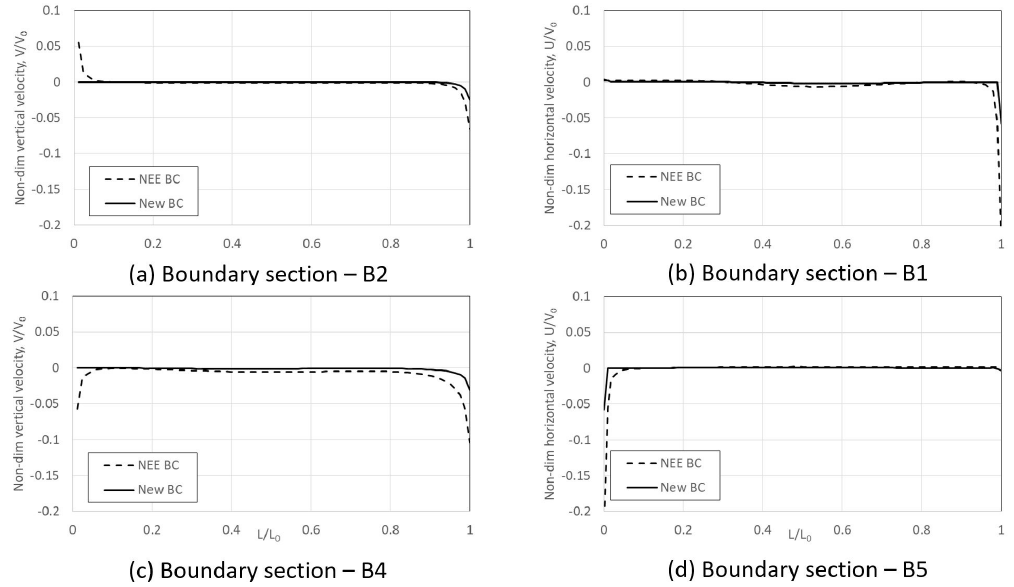
Figure 11. Perpendicular velocity profiles along different boundaries using the newly developed mass-conserved and NEE boundary conditions for a multiple right bending pipe: ( a ) B2; ( b ) B1; ( c ) B4; ( d )